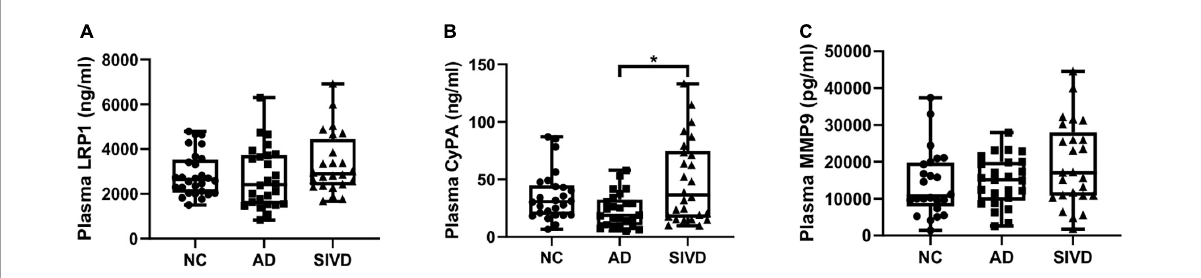
FIGURE1 Box and dot plots of plasma (A) s LRP1, (B) CyPA, and (C) MMP9 per diagnostic group. Analytes with significant differences between diagnostic groups are shown. * p = 0.018.